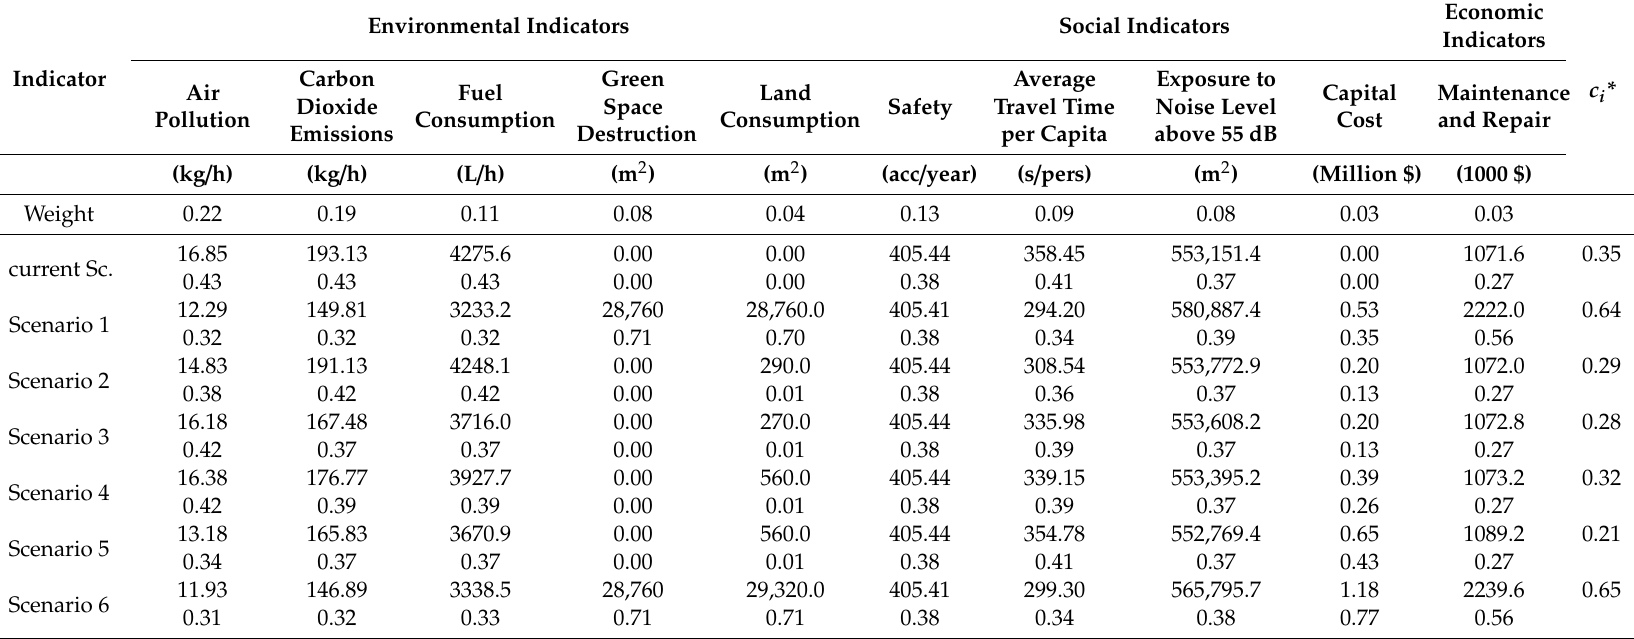
Table 4. Values of indicators and technique for order of preference by similarity to ideal solution (TOPSIS)